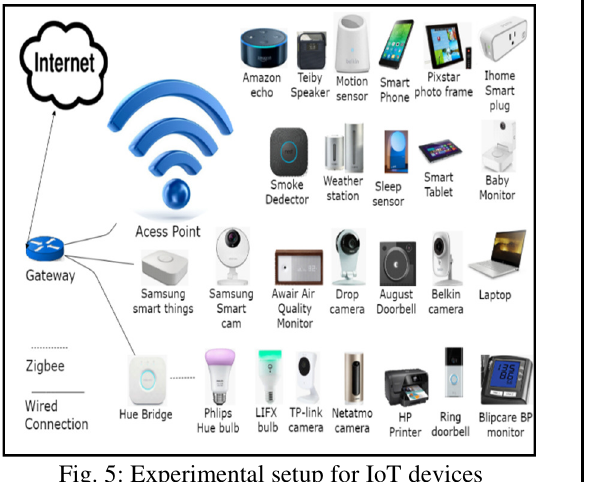
Fig. 5: Experimental setup for IoT devices